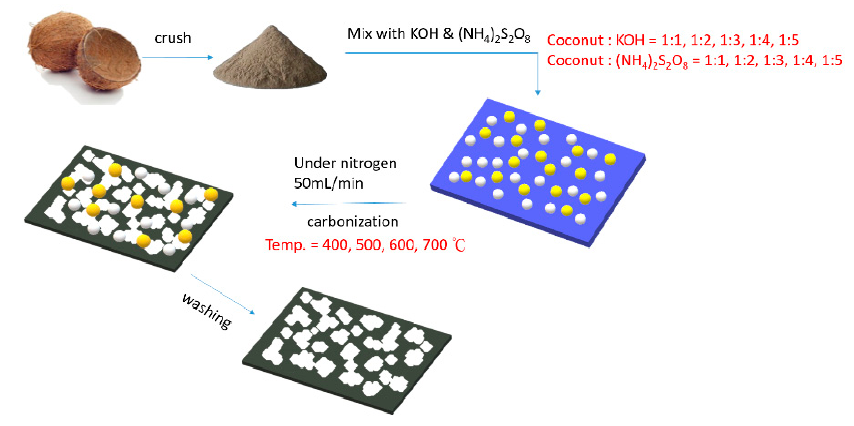
Table 1. The preparatory conditions of the as-prepared activated carbon obtained using coconut shell as raw